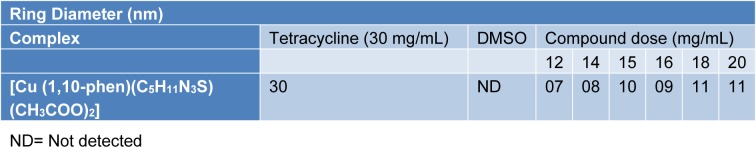
Comparison of MIC values (in mg/mL) of Cu(II) complex and standard antibiotic tetracycline against S. aureus